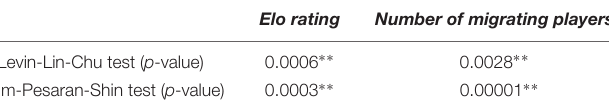
TABLE 2 | Panel unit root tests.